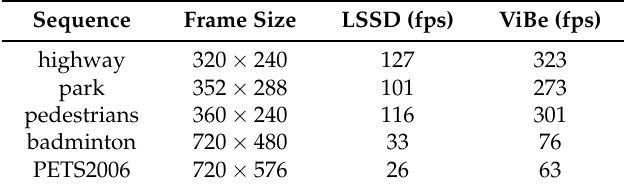
Table 6. LSSD and ViBe computational speed comparison in terms of frame per seconds